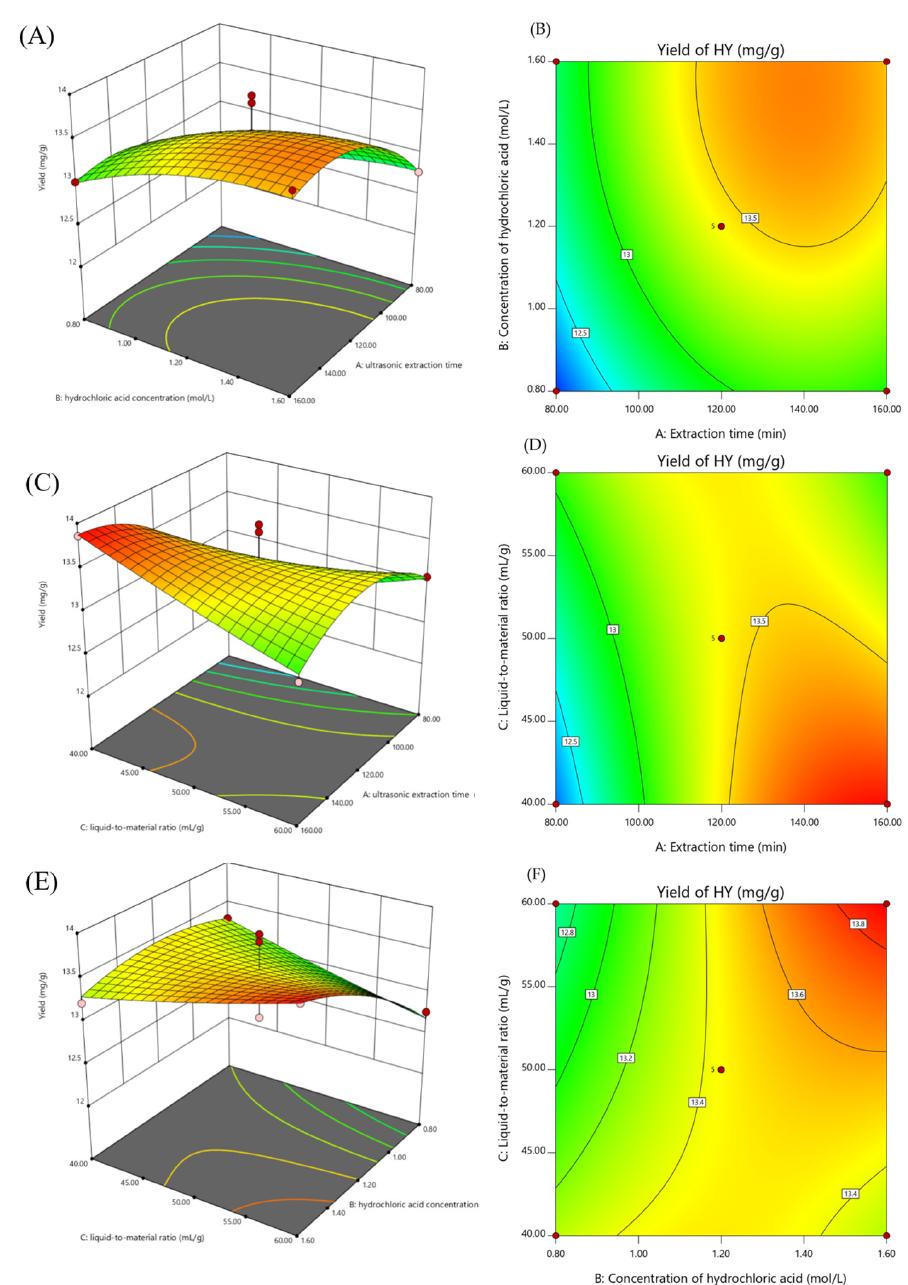
Figure 2. The 3D ( A ) and contour plots ( B ) of the interaction between extraction time and concentra- tion of hydrochloric acid. The 3D ( C ) and contour plots ( D ) of the interaction between extraction time and liquid-to-material ratio. The 3D ( E ) and contour plots ( F ) of the interaction between concentration of hydrochloric acid and liquid-to-material ratio.